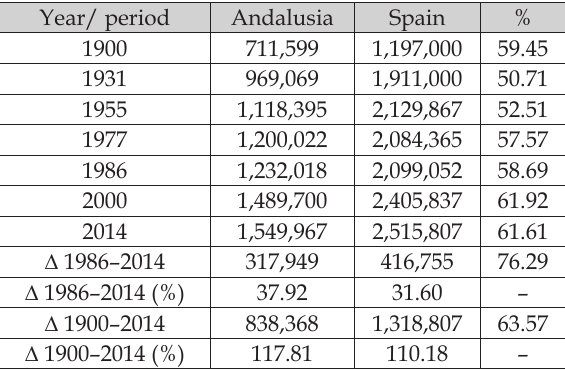
Table 2. Increase in and concentration of the area